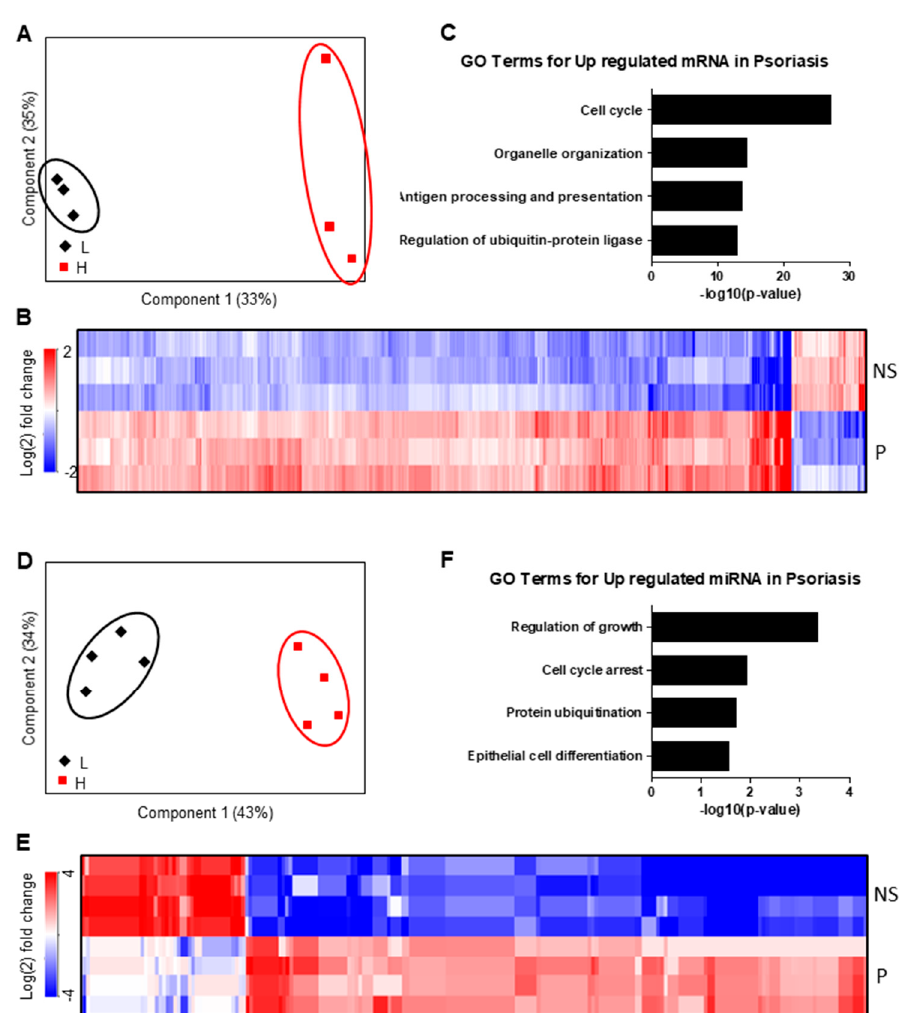
Figure 6. miRNA and mRNA alterations in psoriasis. ( A ) Samples are displayed based on their mRNA expression with respect to the first two components (L lesional skin; H healthy skin). The two conditions are clearly separated from each other. ( B ) The heatmap displays 141 (upregulated red; downregulated blue) significantly regulated miRNAs. ( C ) Target genes of the upregulated miRNAs in psoriasis lesions are associated with the cell cycle process and epithelial cell differentiation. ( D ) mRNA expression characteristics of the same samples are displayed in the PCA. ( E ) The heatmap shows 1987 (upregulated red; downregulated blue) differentially expressed mRNAs. ( F ) Upregulated genes in psoriasis skin are associated with the cell cycle processes. n = 3 for A–C; n = 4 for D–E.